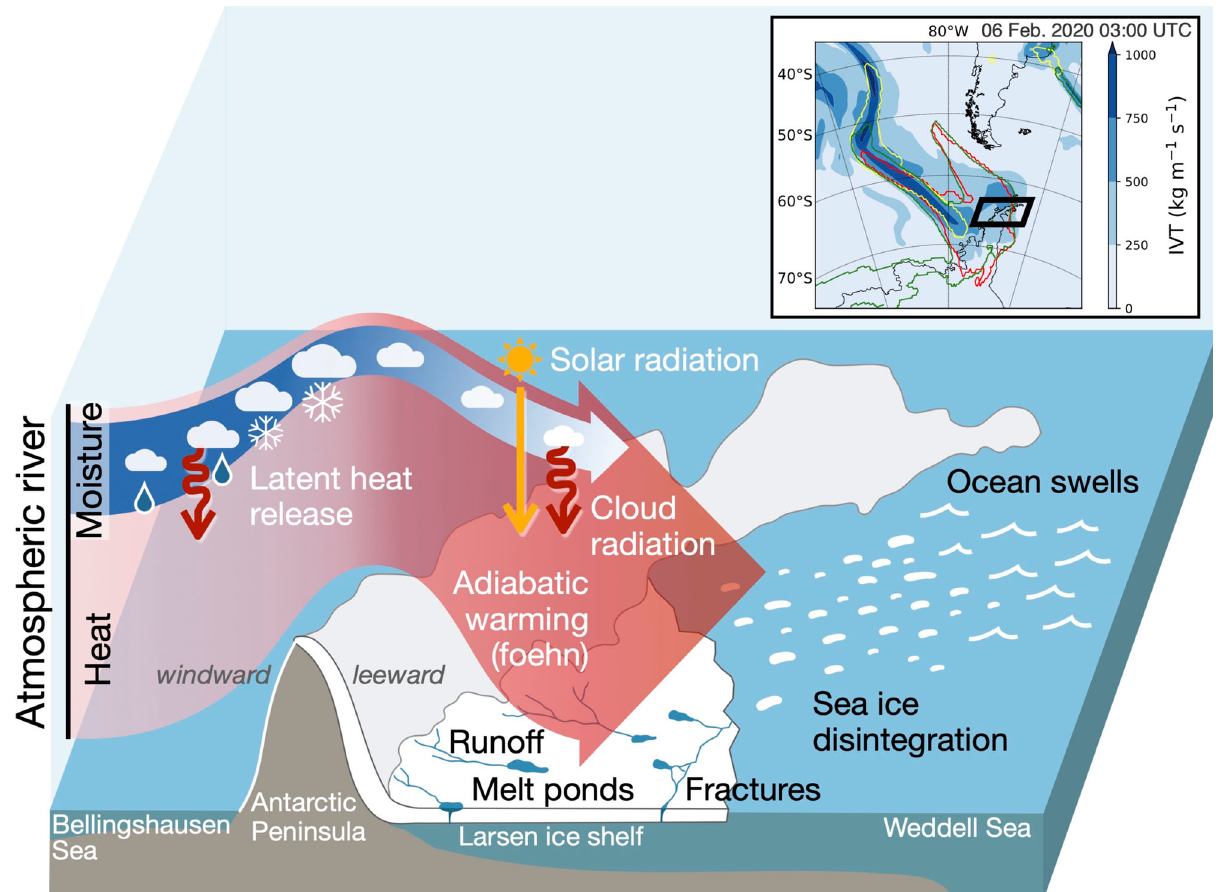
Fig. 4 Illustration of an AR landfall on the AP. An illustration of a typical intense atmospheric river over the northern Antarctic Peninsula and the associated observed meteorological features and impacts consequential to ice-shelf stability. Also, an example of a detected AR landfall on Feb. 6th, 2020, with the corresponding IVT values. The yellow, red, and green outlines are the shape of the AR as determined by the vIVT AR detection scheme, IWV AR detection scheme, and the original Antarctic AR detection algorithm, respectively 17, 19 . The satellite imagery in Supplementary Fig. 21 is an accurate representation of the AR airmass adiabatically warming and drying as it passes over the AP mountains leaving scattered cloud cover over the leeward Larsen B ice